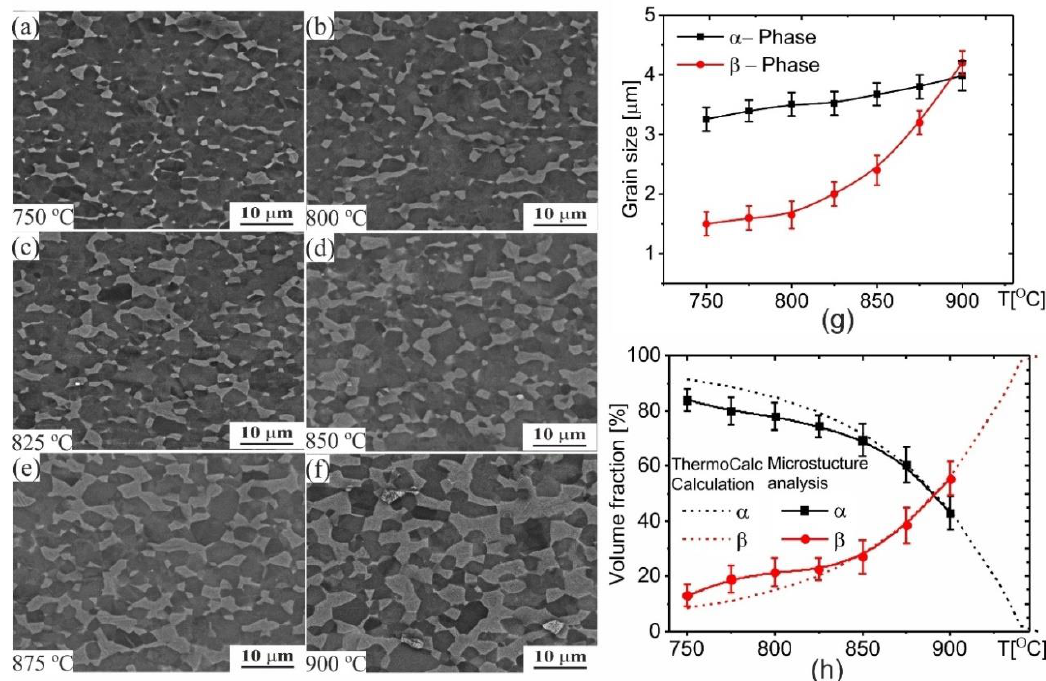
Figure 1. Microstructure evolution of the investigated alloy after 30 min annealing at different temperatures: ( a ) 750 °C, ( b ) 800 °C, ( c ) 825 °C, ( d ) 850 °C, ( e ) 875OC and ( f ) 900 °C; ( g ) quantitative analysis of grain size, ( h ) quantitative analysis of volume fraction.